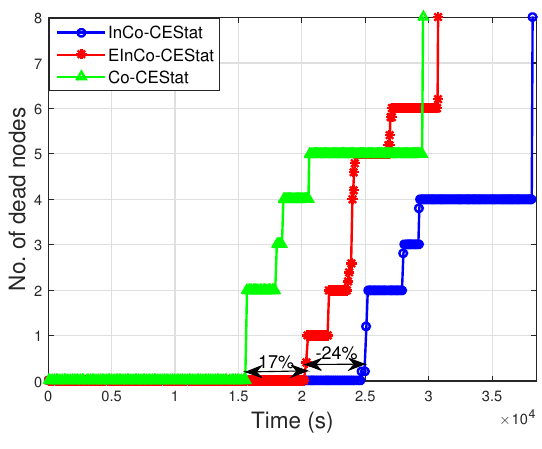
Figure 6. Stability period and network